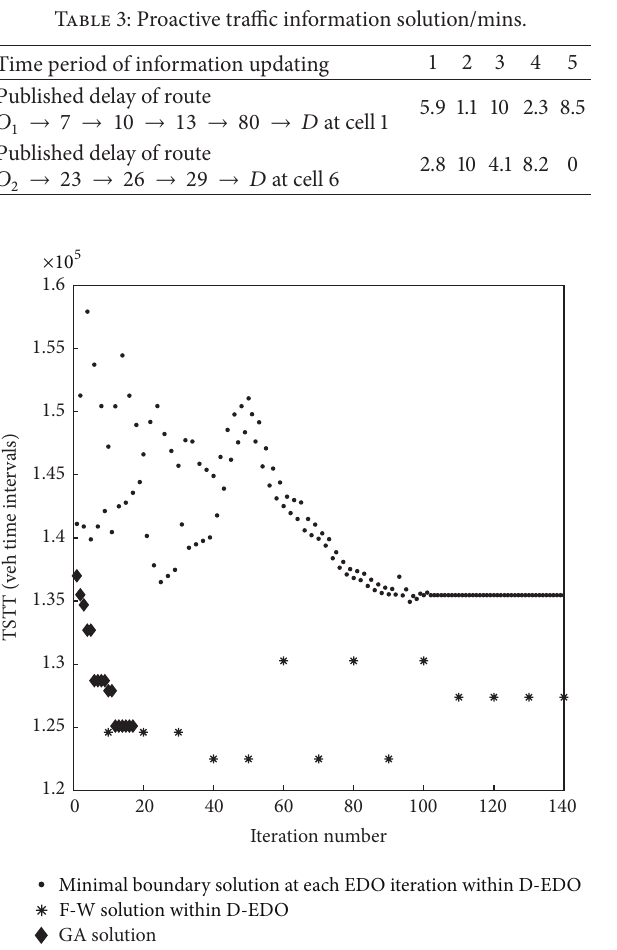
Figure 4: Convergence comparison about the solutions between D- EDO and